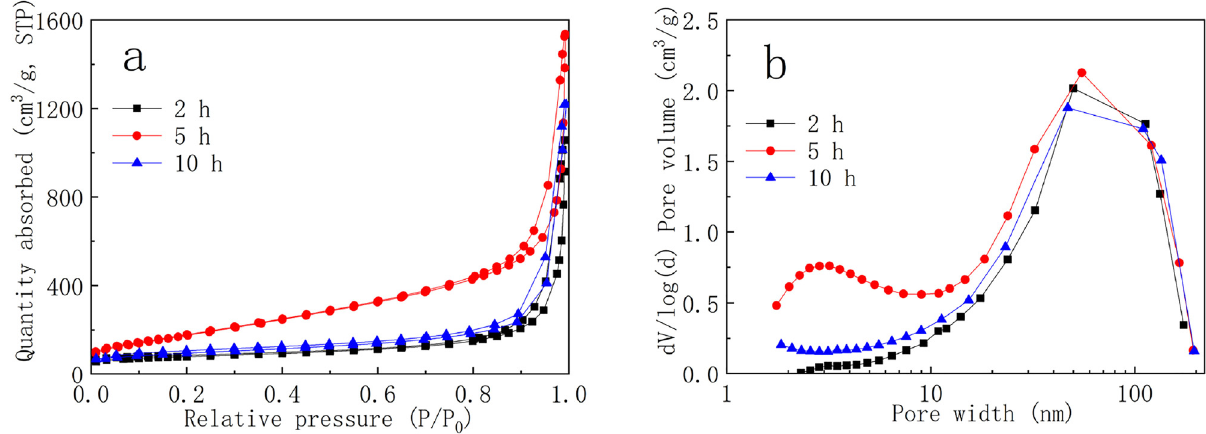
Figure 4: N 2 adsorption desorption isotherms ( a ) and pore size distribution curves ( b ) of C/SiO 2 aerogels with di ff erent heat treatment time.